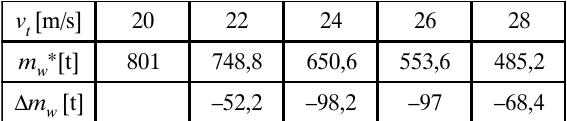
Table 1. Variation of train-car optimal mass